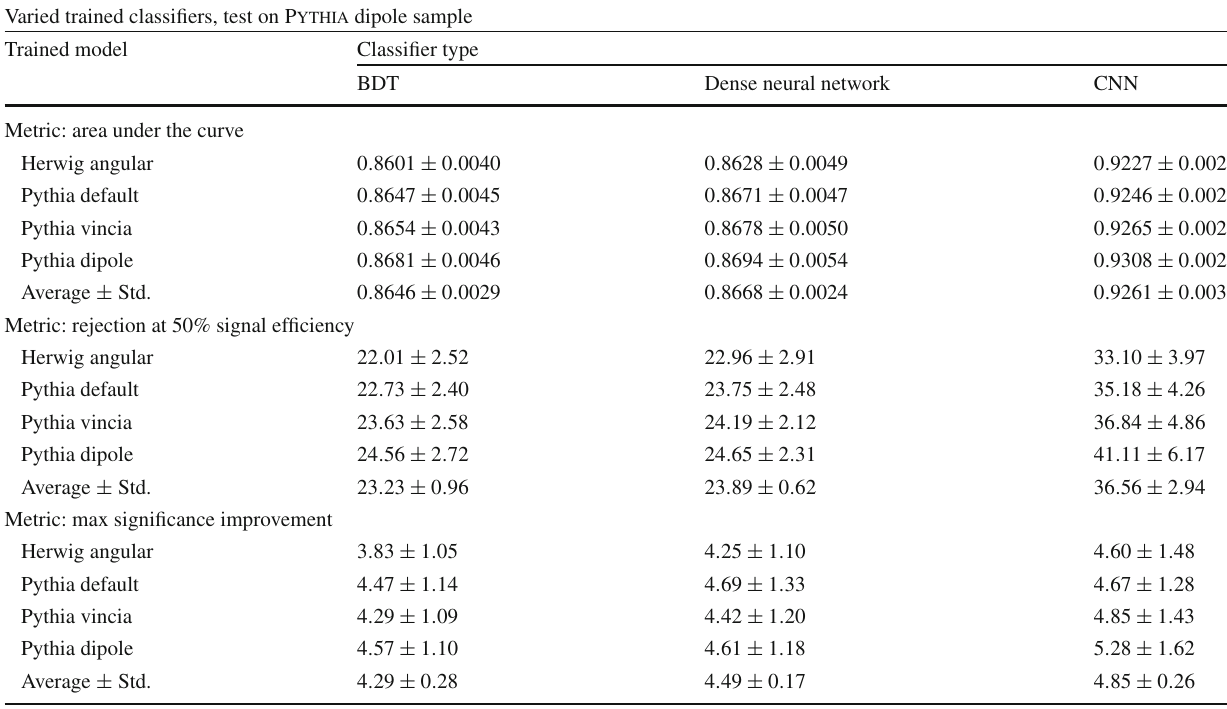
Table 4 Area under the curve, rejection at 50% signal efficiency and maximum significance improvement when testing on Pythia dipole for each trained classifier. The last rows are the average and standard deviation over the mean values from the other rows Varied trained classifiers, test on Pythia dipole